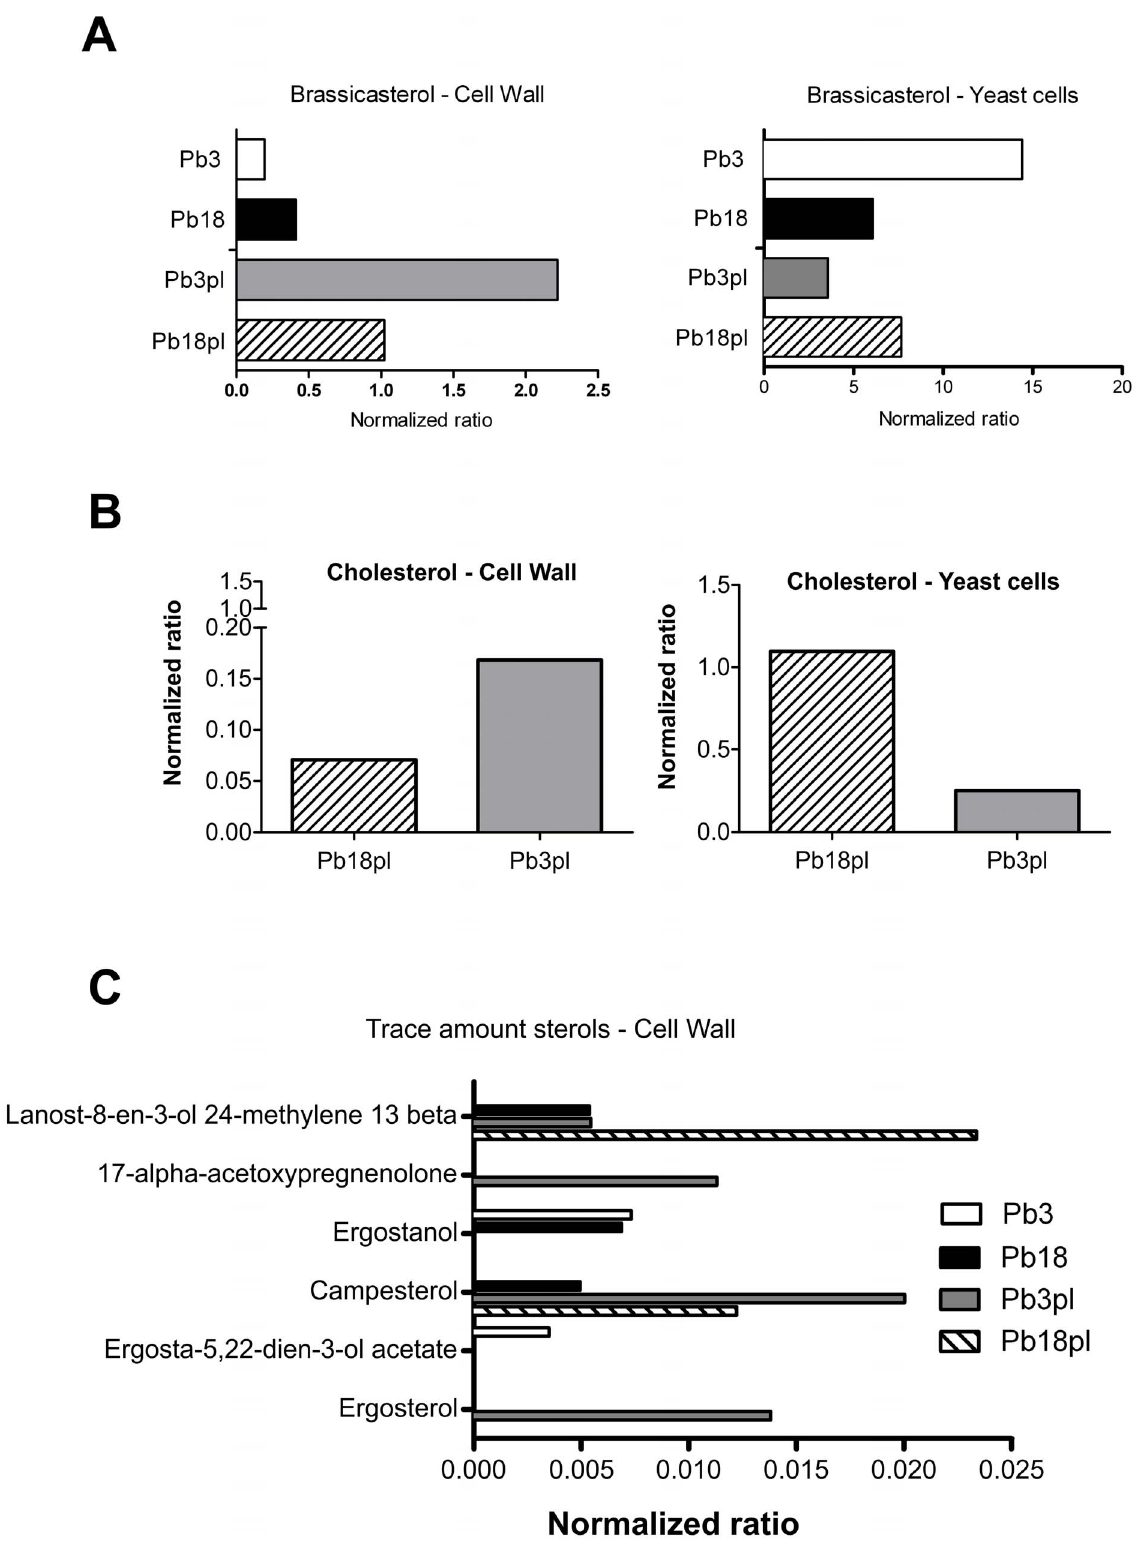
Figure 4. Comparison of cell wall and total yeast cell sterols from Pb3 and Pb18 cultivated in the presence (pl) or absence of plasma. Sterols were analyzed by GC-MS and abundance was normalized to the stigmasterol (internal standard). A, Comparison of brassicasterol amounts, the most the most abundant sterol detected. B, Cholesterol uptake from plasma by Pb3 and Pb18 isolates. C, Comparison of sterols found in trace amounts in cell wall samples.